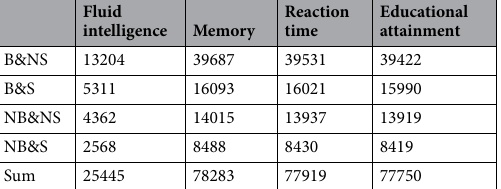
Table 1. The number of samples for the status of breastfeeding and maternal smoking around birth. B&NS: breastfed and not exposed to maternal smoking around birth, B&S: breastfed and exposed to maternal smoking around birth, NB&NS: not breastfed and not exposed to maternal smoking around birth, and NB&S: not breastfed and exposed to maternal smoking around